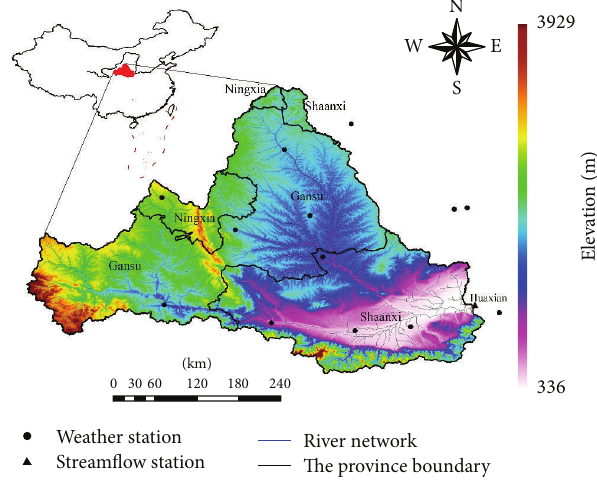
Figure 1: Map of study